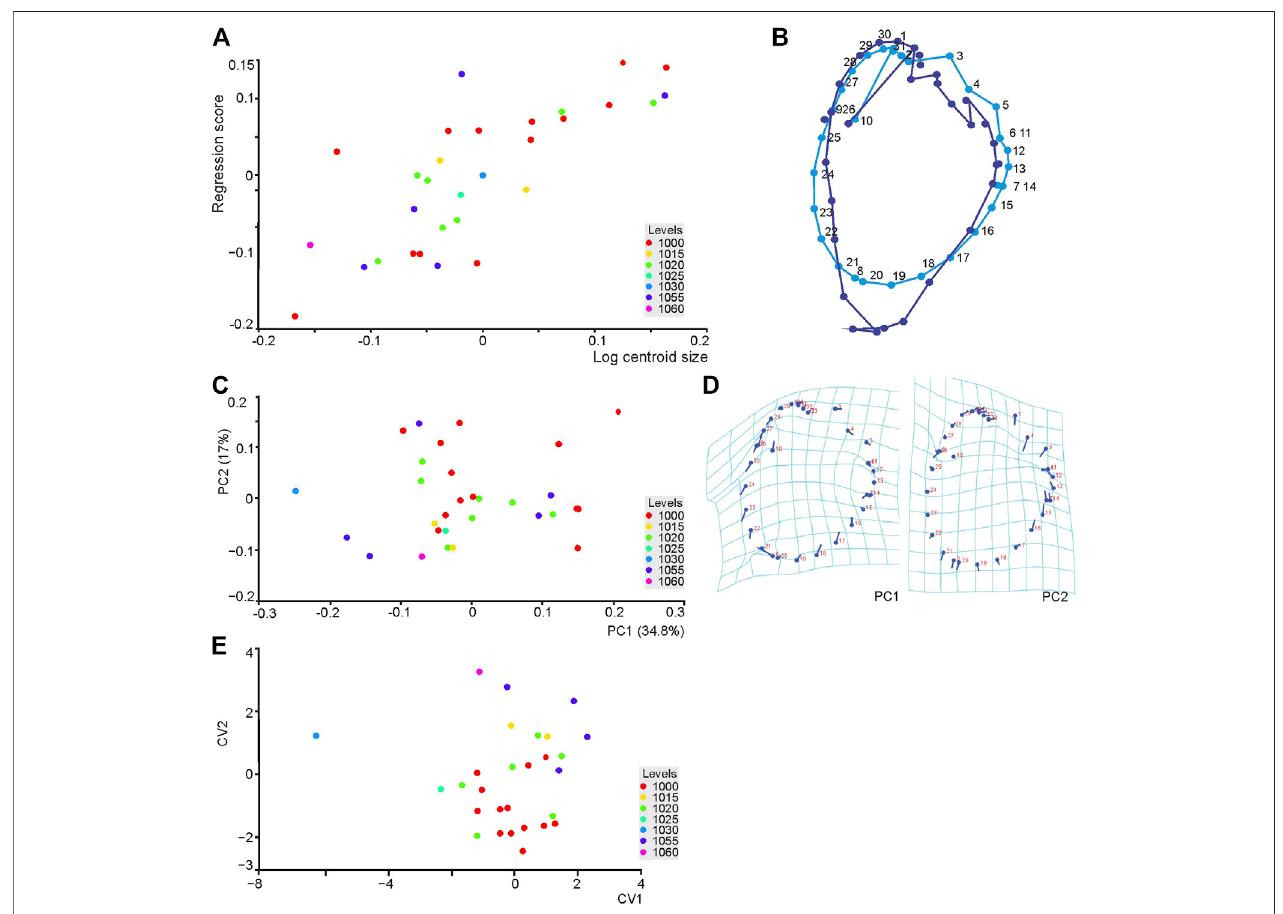
FIGURE 10 | (A,B) Multivariate regression of the TCH pes shape, via curving landmarks, onto size (as the logarithm of centroid size) classi fi ed by Level, and re fl ecting shape changes. (C,D) Principal component analysis plot of PC1 vs. PC2 and shape changes shown on transformation grids. (E) Canonical variate analysis scatter plot showing the variation in shape of pes tracks along the fi rst two canonical variate (CV1 and CV2) axes.